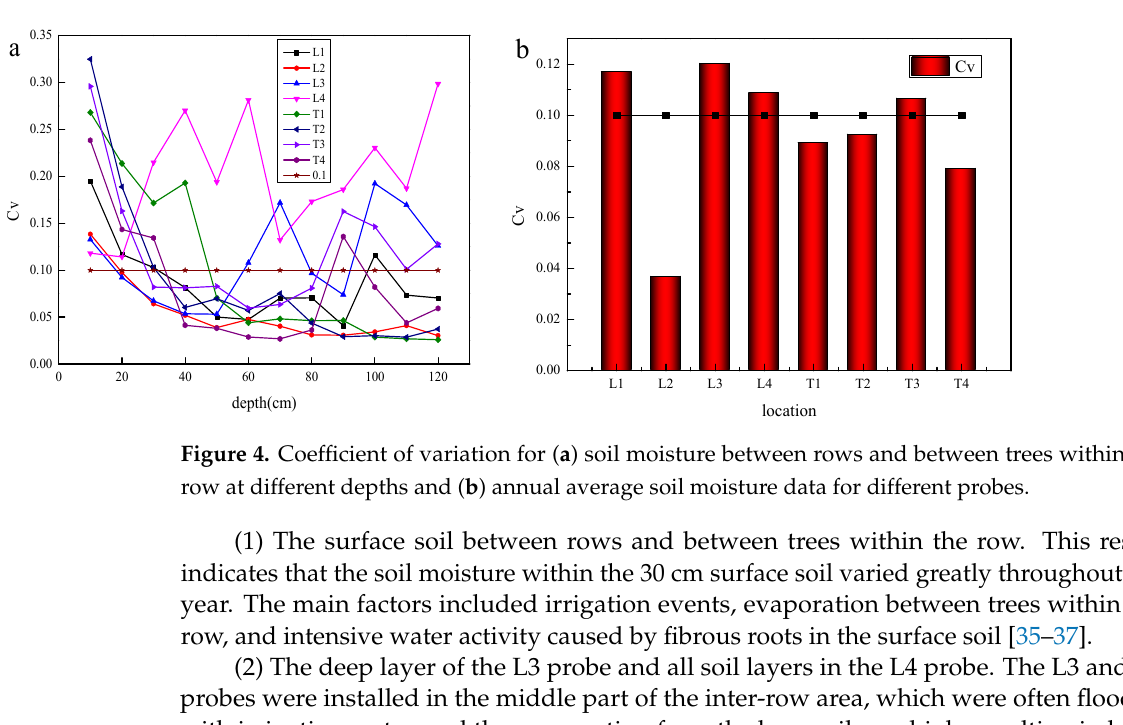
Figure 4. Coefficient of variation for ( a ) soil moisture between rows and between trees within the row at different depths and ( b ) annual average soil moisture data for different probes.